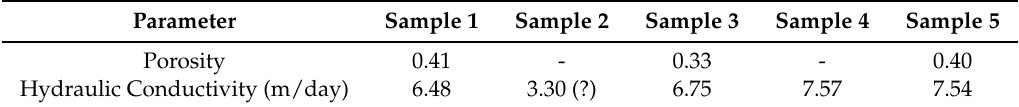
Table 1. Soil porosity and hydraulic conductivity